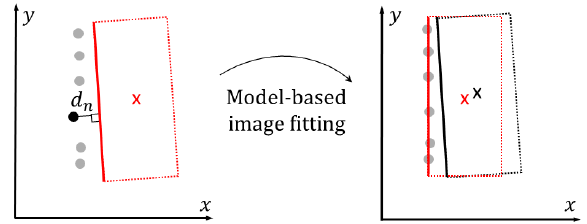
Figure 10. Projected rectangular model (before and after the